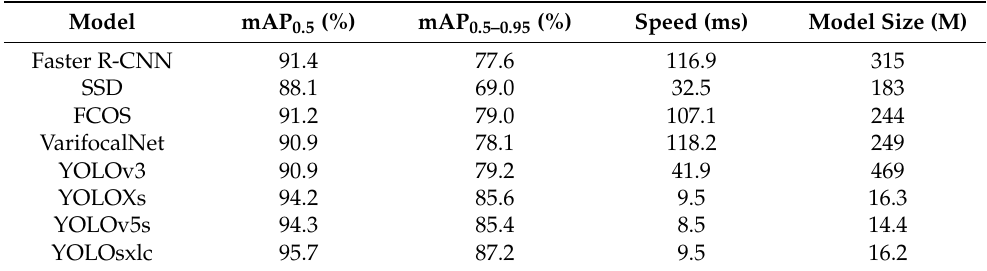
Table 6. Comparison of performance of different object detection